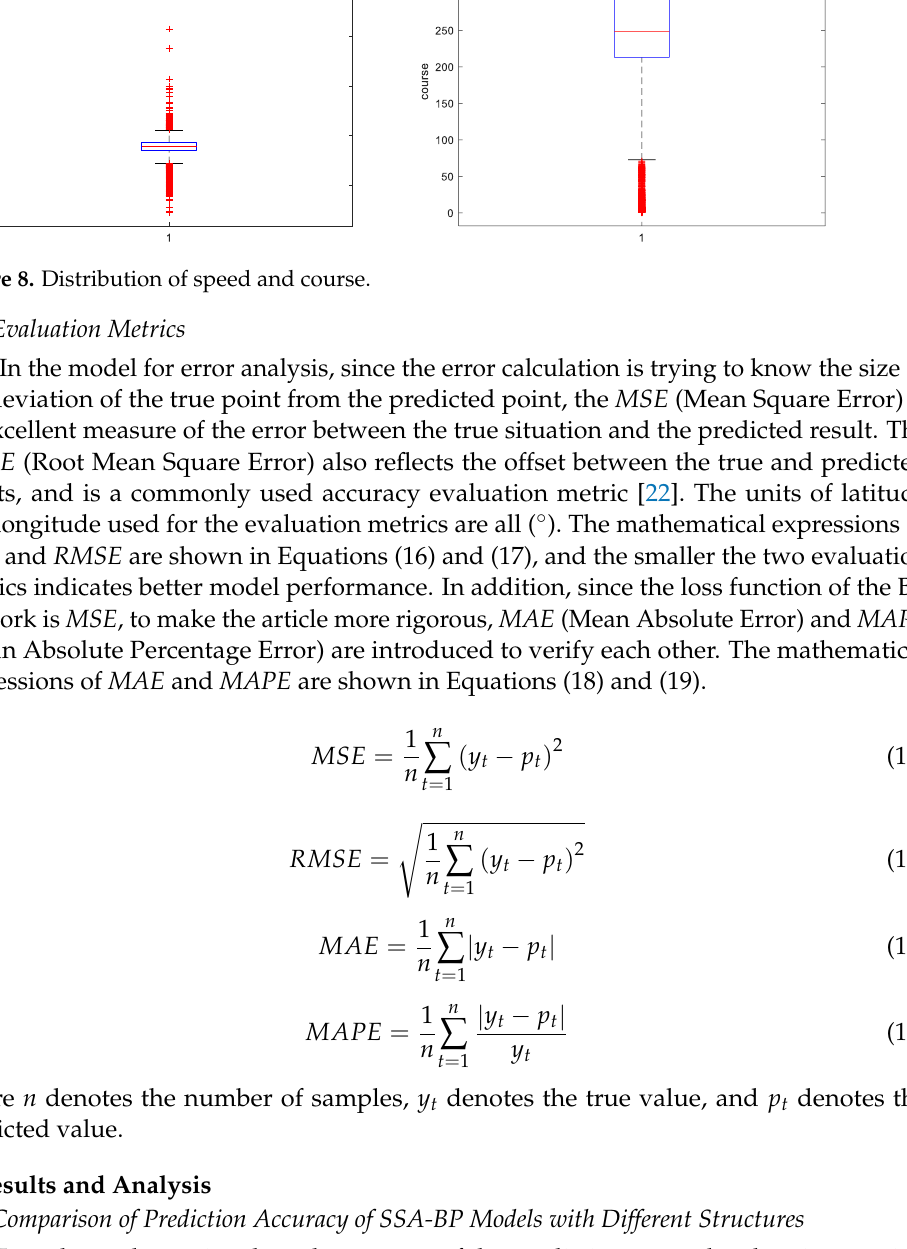
Figure 7. Distribution of longitude and latitude.